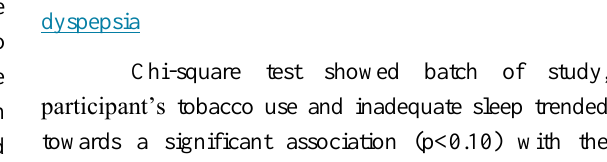
Table 5: Association between dietary factors and